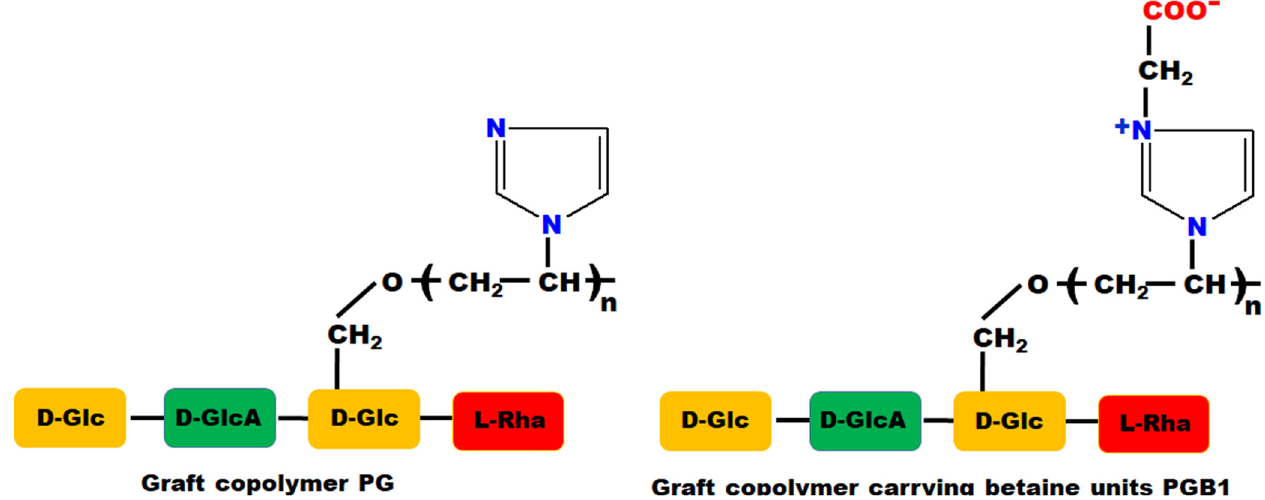
Figure 1. Chemical structure of PG and PGB1 graft porous copolymers .